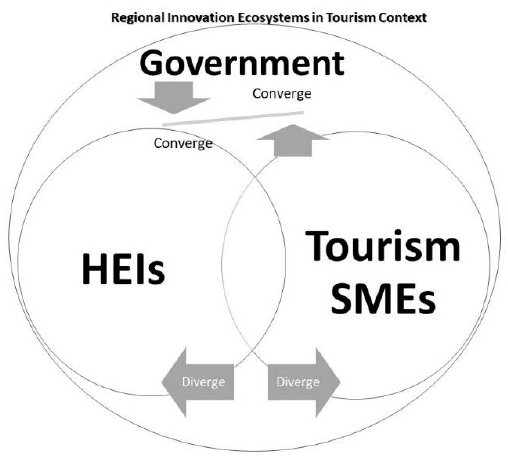
Figure 1. Triple Helix in Tourism Context.